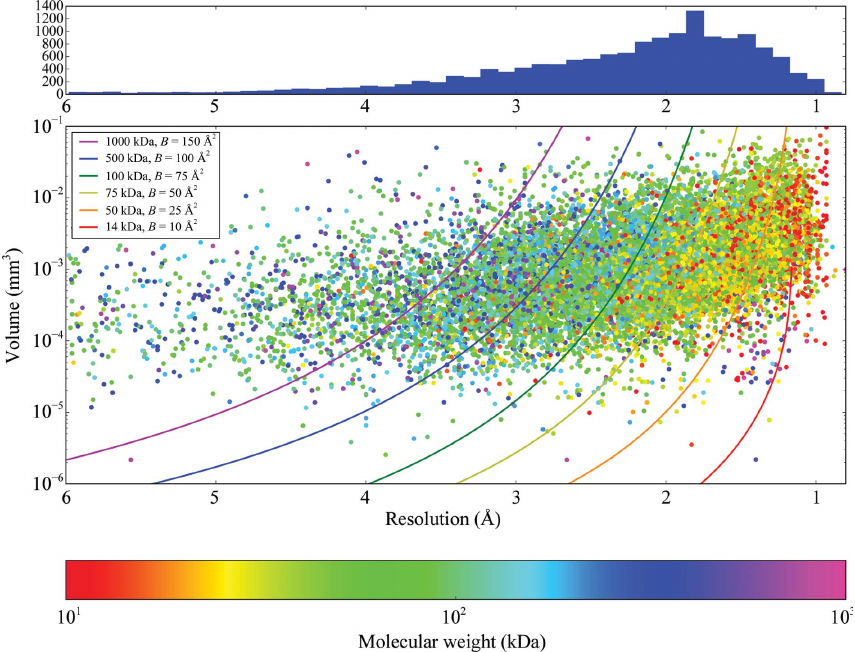
Figure 6 The relationship between crystal volume, obtained resolution and molecular weight. The crystal volume is plotted against the highest resolution cutoff from autoprocessing and is coloured by the molecular weight of the entity crystallized; note the logarithmic scales for volume and molecular weight. Lines describe the minimum crystal volume required for a certain resolution given the parameters shown assuming a Nave–Hill effect (photoelectron escape) of 1, as all crystals are larger than 1 m m 3 , and 100 photons per hkl (equation 16 from Holton & Frankel, 2010). The lines indicate a specific molecular weight and B factor and should be taken as a guide to the rough range described. The wavelength on MASSIF-1 is fixed and the beam diameter is altered to match the crystal. The histogram shows the distribution of resolutions obtained in the scatter plot. N = 15 241.